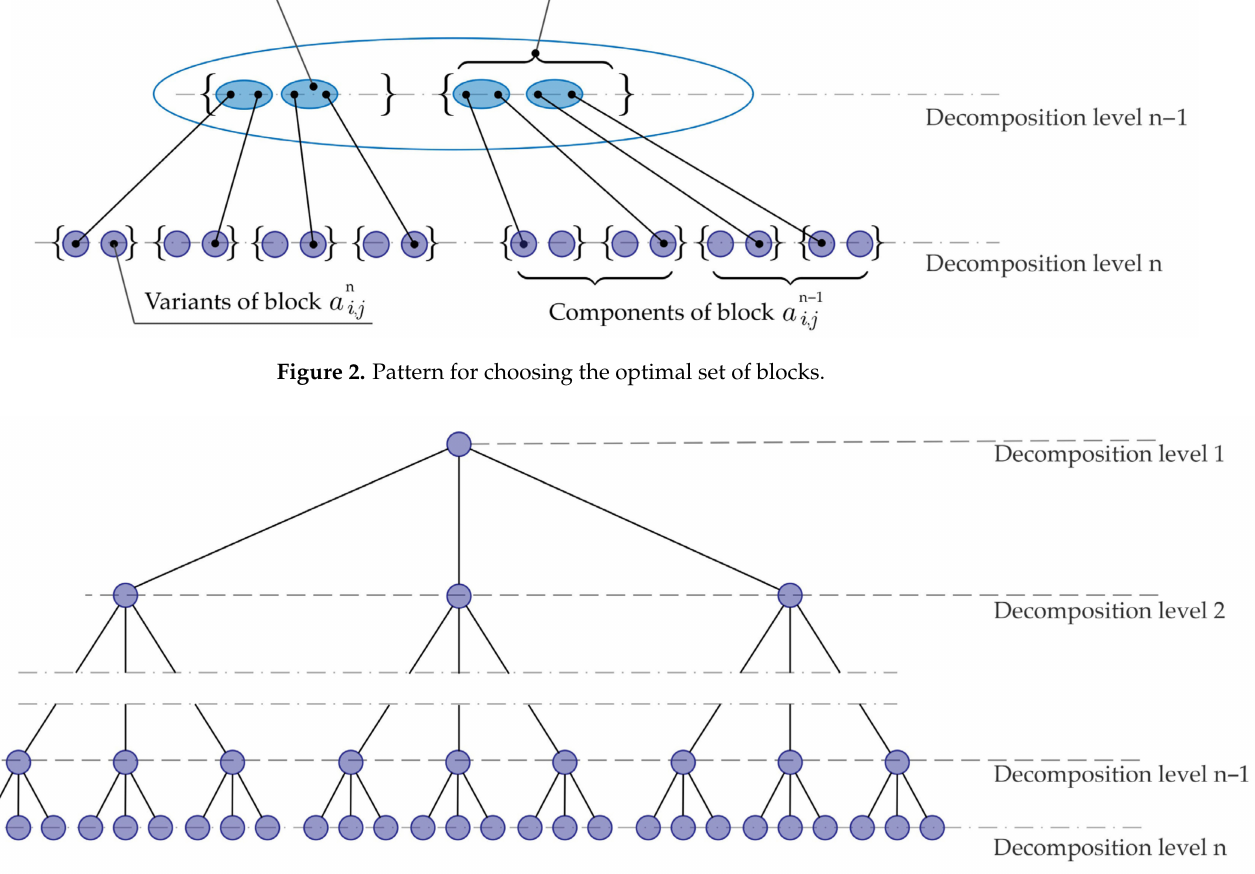
Figure 3. Tree from with a minimum weight of the upper